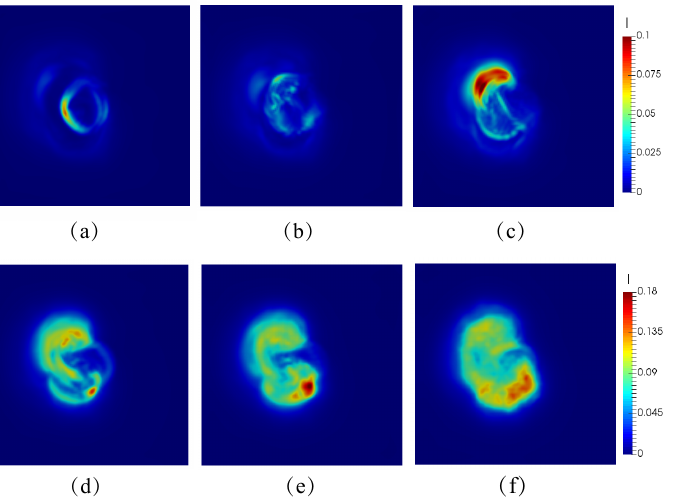
Figure 15. Contours of instantaneous turbulence intensity in a vertical plane at hub height: ( a ) 1D downstream of WT1; ( b ) 4D downstream of WT1; ( c ) 6D downstream of WT1; ( d ) 1D downstream of WT2; ( e ) 2D downstream of WT2; ( f ) 4D downstream of